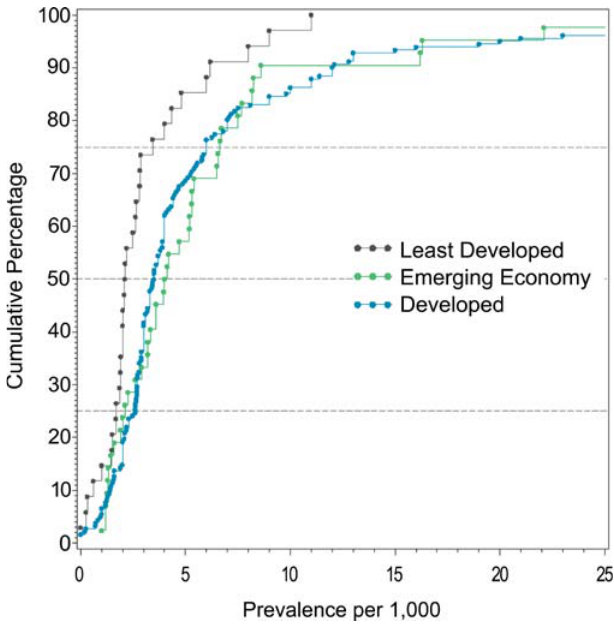
Figure 12. Cumulative Plots of the Combined Prevalence Estimates per 1,000 for Persons by Economic Status of Country DOI: